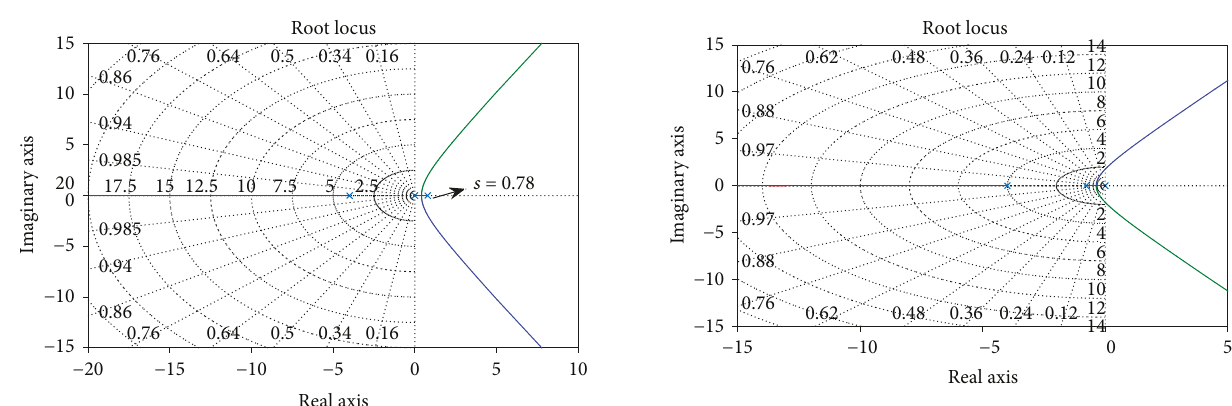
Figure 5: Root locus of zero-pole of stable system.